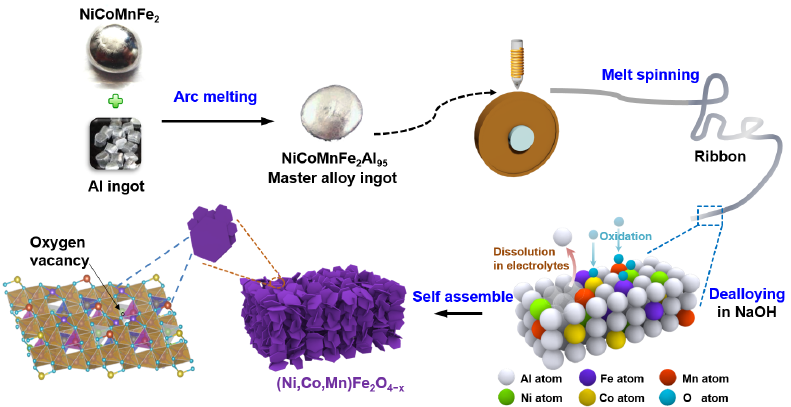
Figure 1. Schematic revealing the preparation process of (Ni,Co,Mn)Fe 2 O 4-x .